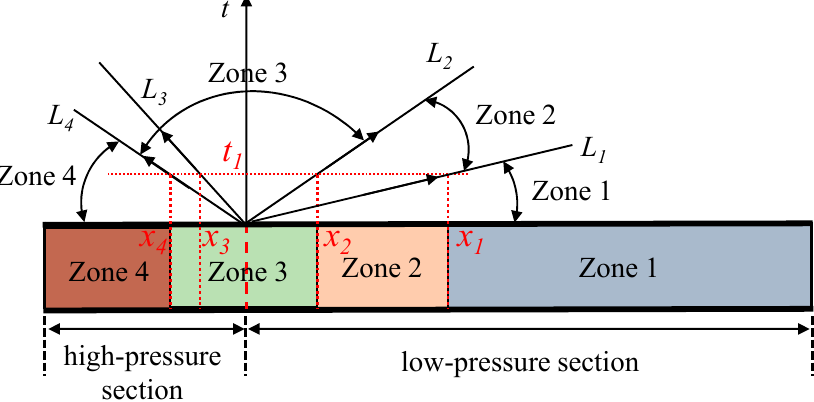
Figure 5. Region division and wave system diagram in shock tube.